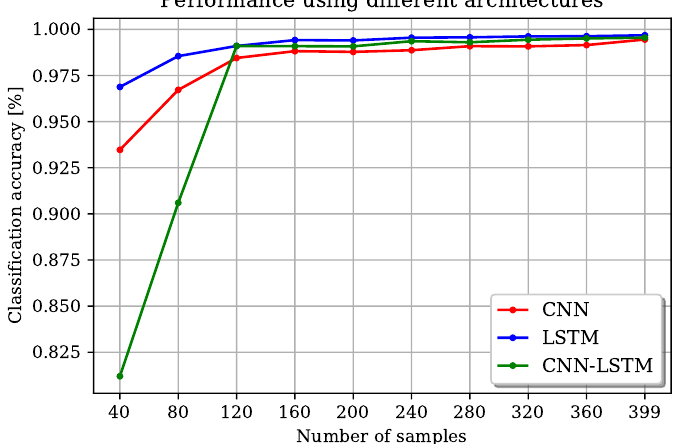
Figure 6. Accuracy of three proposed architectures (CNN, LSTM, and CNN-LSTM) for different numbers of samples per